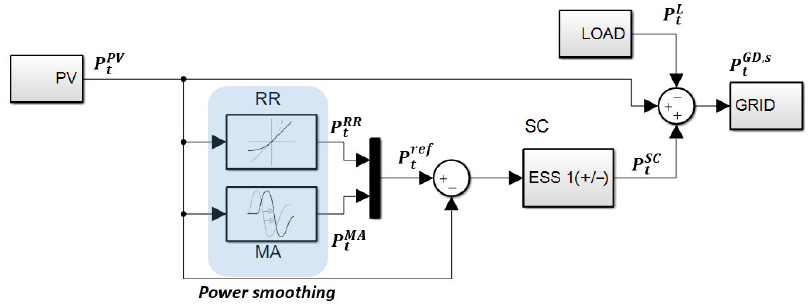
Figure 6. Control diagram, power smoothing methods for a system (PV + SC).